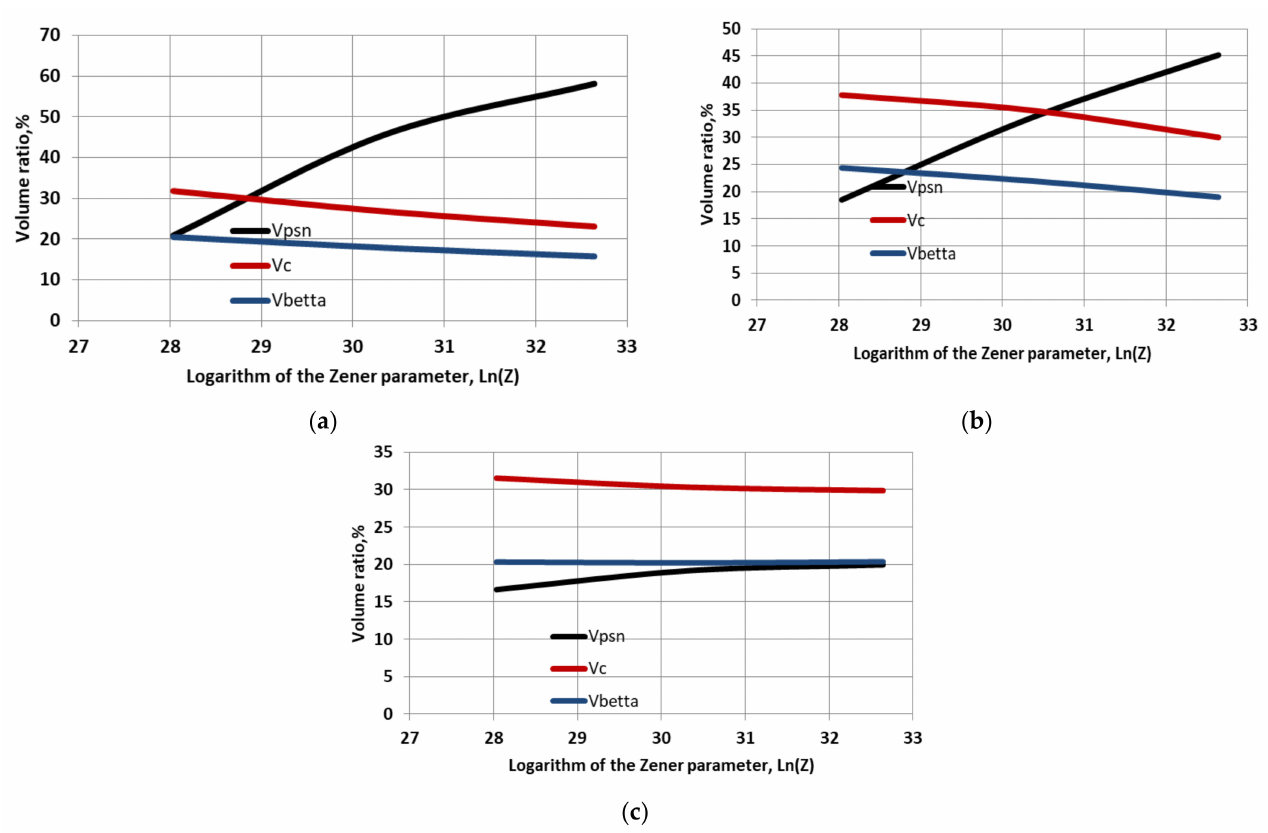
Figure 18. Calculated dependence of the recrystallization textures on the Zener–Hollomon parameter, taking fragmentation of the intermetallic compounds into account: ( a ) 1565 alloy, ( b ) 5182 alloy, ( c ) 8011 alloy.